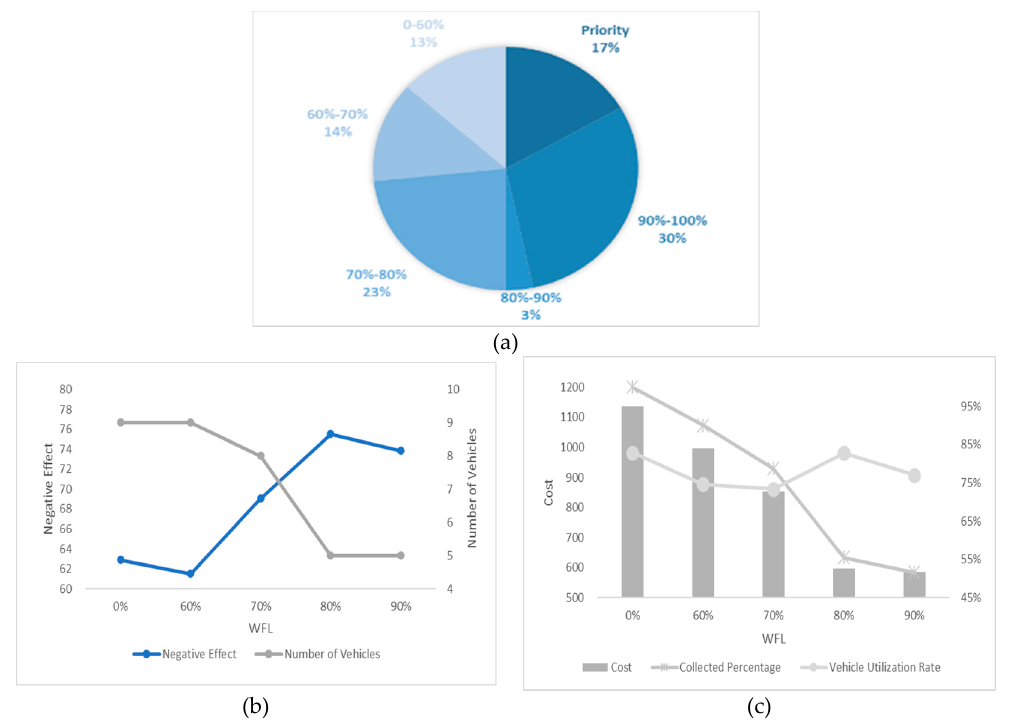
Figure 12. Results with 5 high-priority waste bins. ( a ) PCS-5 distribution of various waste bins, ( b ) PCS-5 negative effect and number of vehicles and ( c ) PCS-5 cost and vehicle utilization rate.